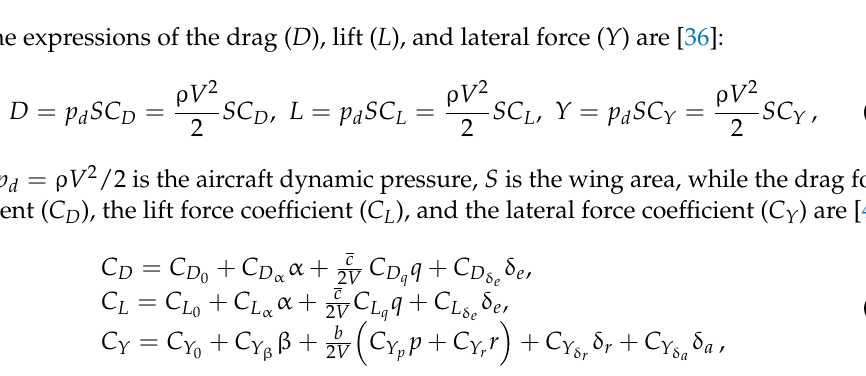
Figure 2. Influence of the attack and sideslip supplementary angles on aircraft motion in longitudinal plane ( a ) and lateral-directional plane ( b